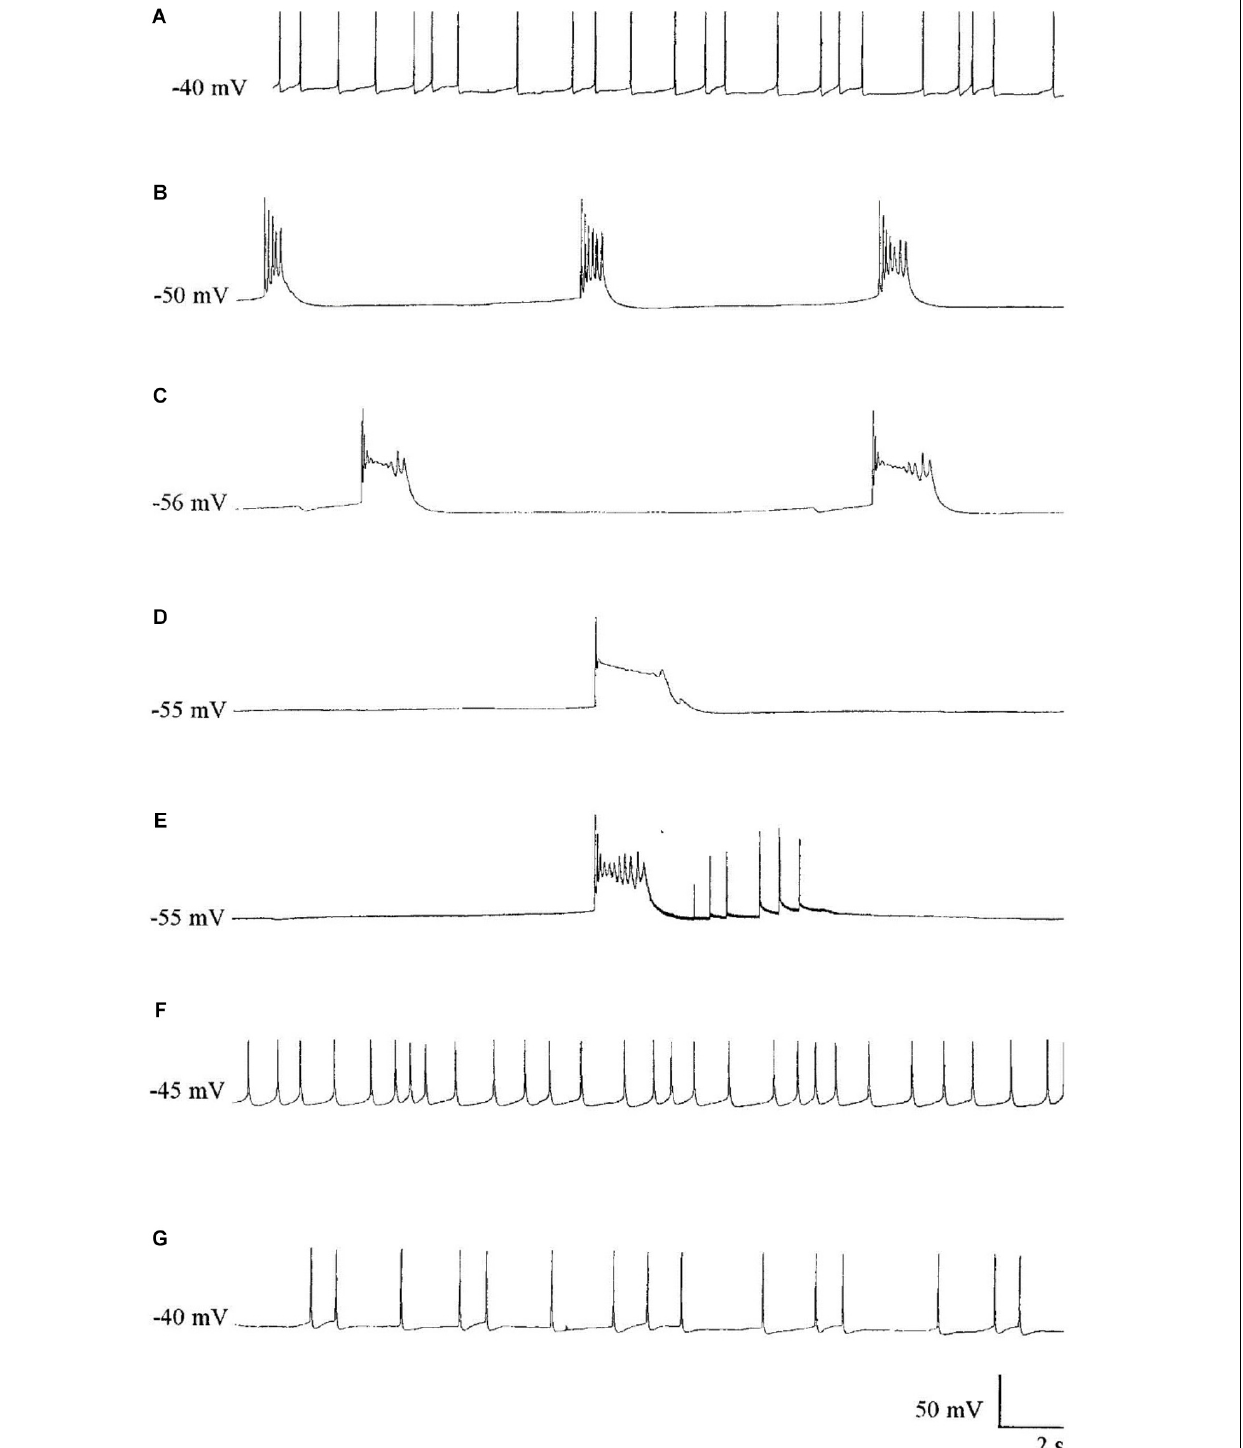
Frontiers in Physiology |